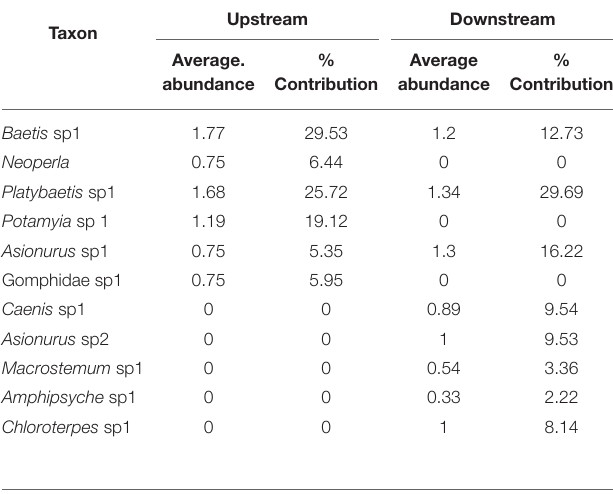
TABLE 7 | The percentage of contribution of all taxa with their average abundance between sampling periods (November–December 2016